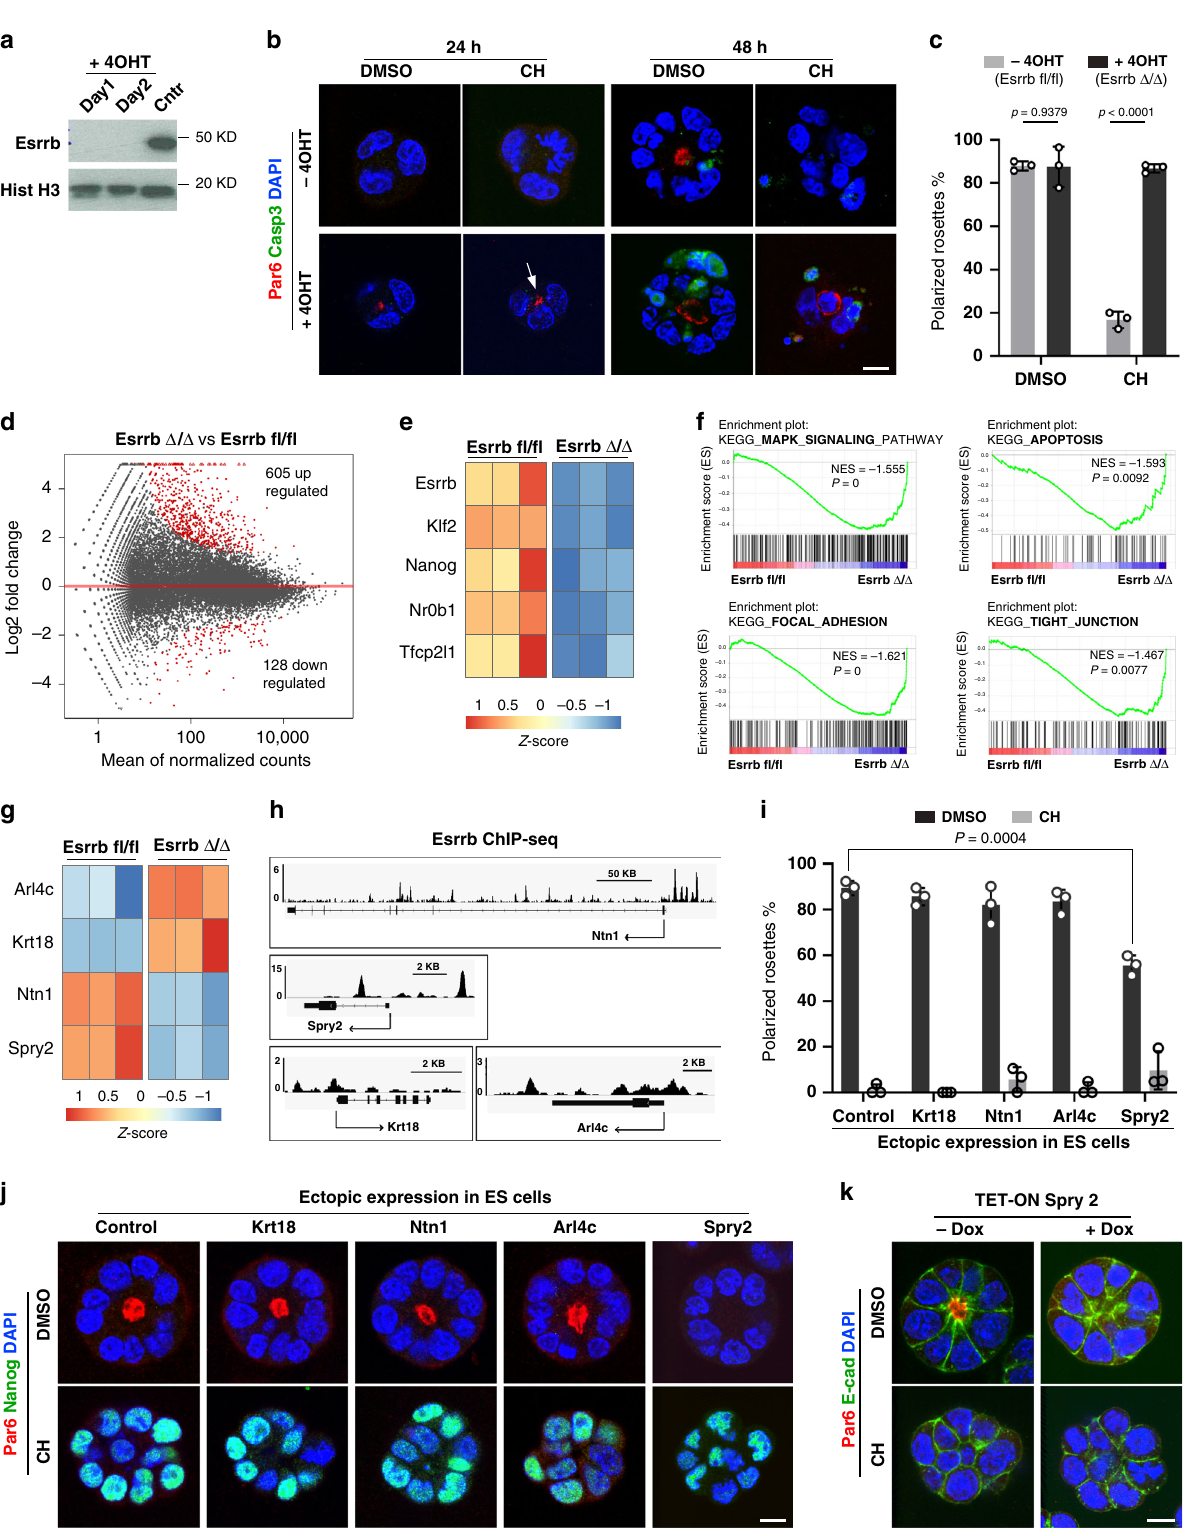
structure. The apical membrane domain surrounded the central microlumen, con fi rming the establishment of the epithelial phenotype in the epiblast (Fig. 5g and Supplementary Fig. 6). Next, we asked whether β -catenin plays a role in the epiblast during diapause. We analysed embryos from heterozygous intercrosses at EDG5.5 and found that β -catenin-de fi cient blastocysts exhibited a complete loss of pluripotent cells, whereas